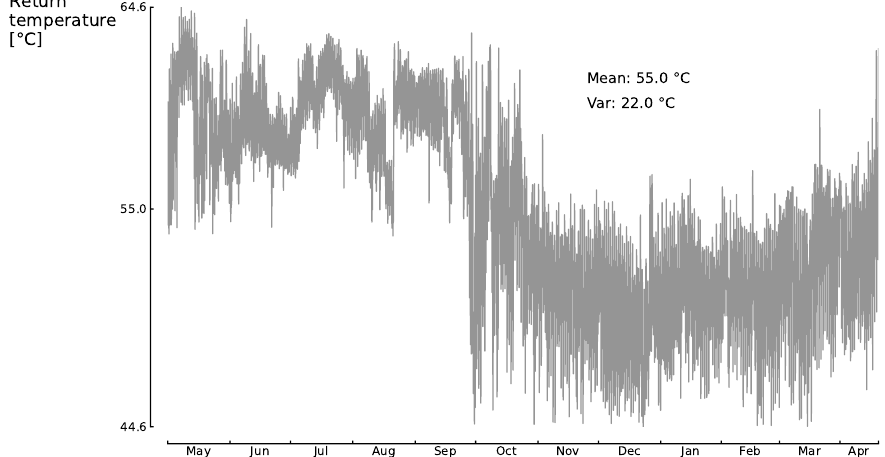
Figure 4. Variability of the return temperature over the sampling periods retrieved from an existing DH plant. The yearly mean return temperatures is 55 °C while the variance is equal to 22